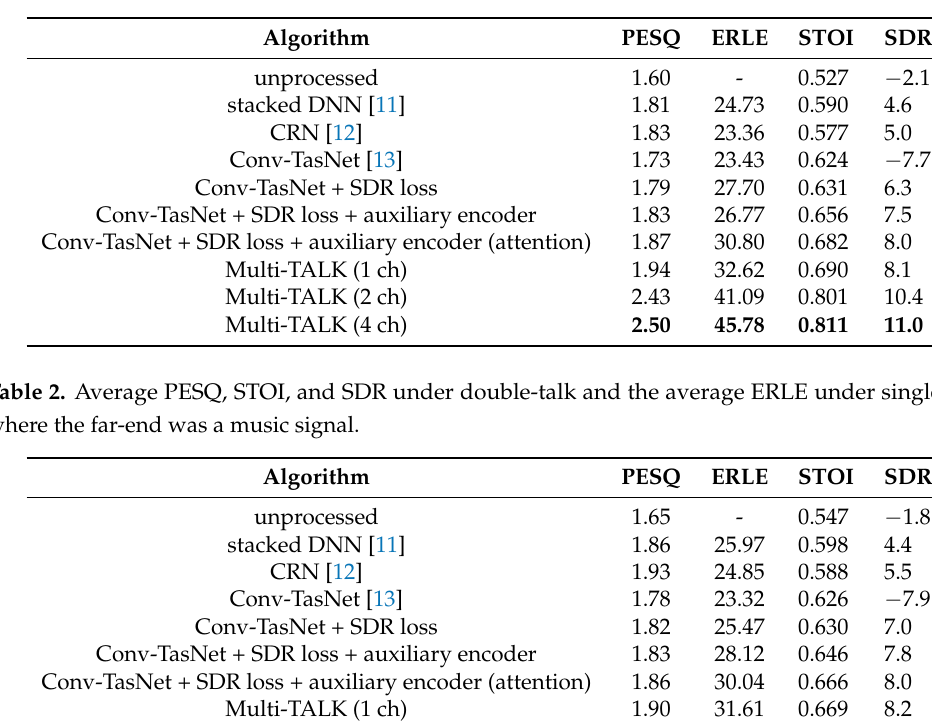
Table 1. Average perceptual evaluation of the speech quality (PESQ), short-time objective intelligibility (STOI), and speech-to-distortion ratio (SDR) under double-talk and the average echo return loss enhancement (ERLE) under single-talk where the far-end was a speech signal. TasNet, time domain audio separation network; Multi-TALK, multi-channel cross-tower with attention mechanisms in latent domain network.